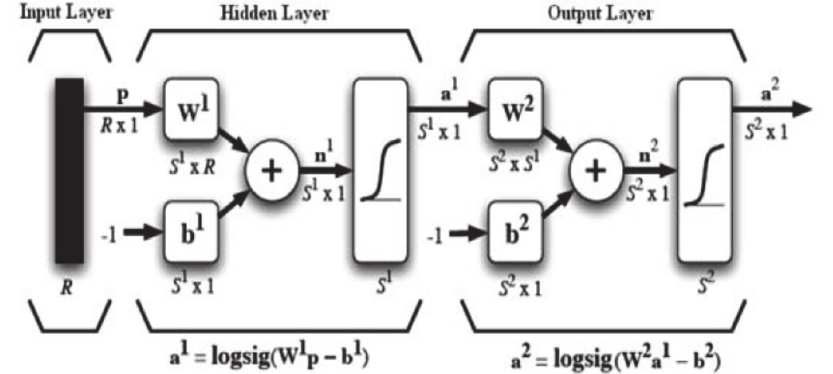
Figure 5: Architecture of MLP neural